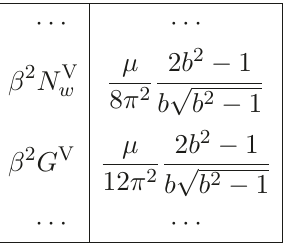
Table 5 . The coefficients of the energy momentum tensor (5.3), the vector current (6.3) and axial current (7.1) for the Dirac field at T = 0 and finite chemical potential µ , where b = µ/m . Open